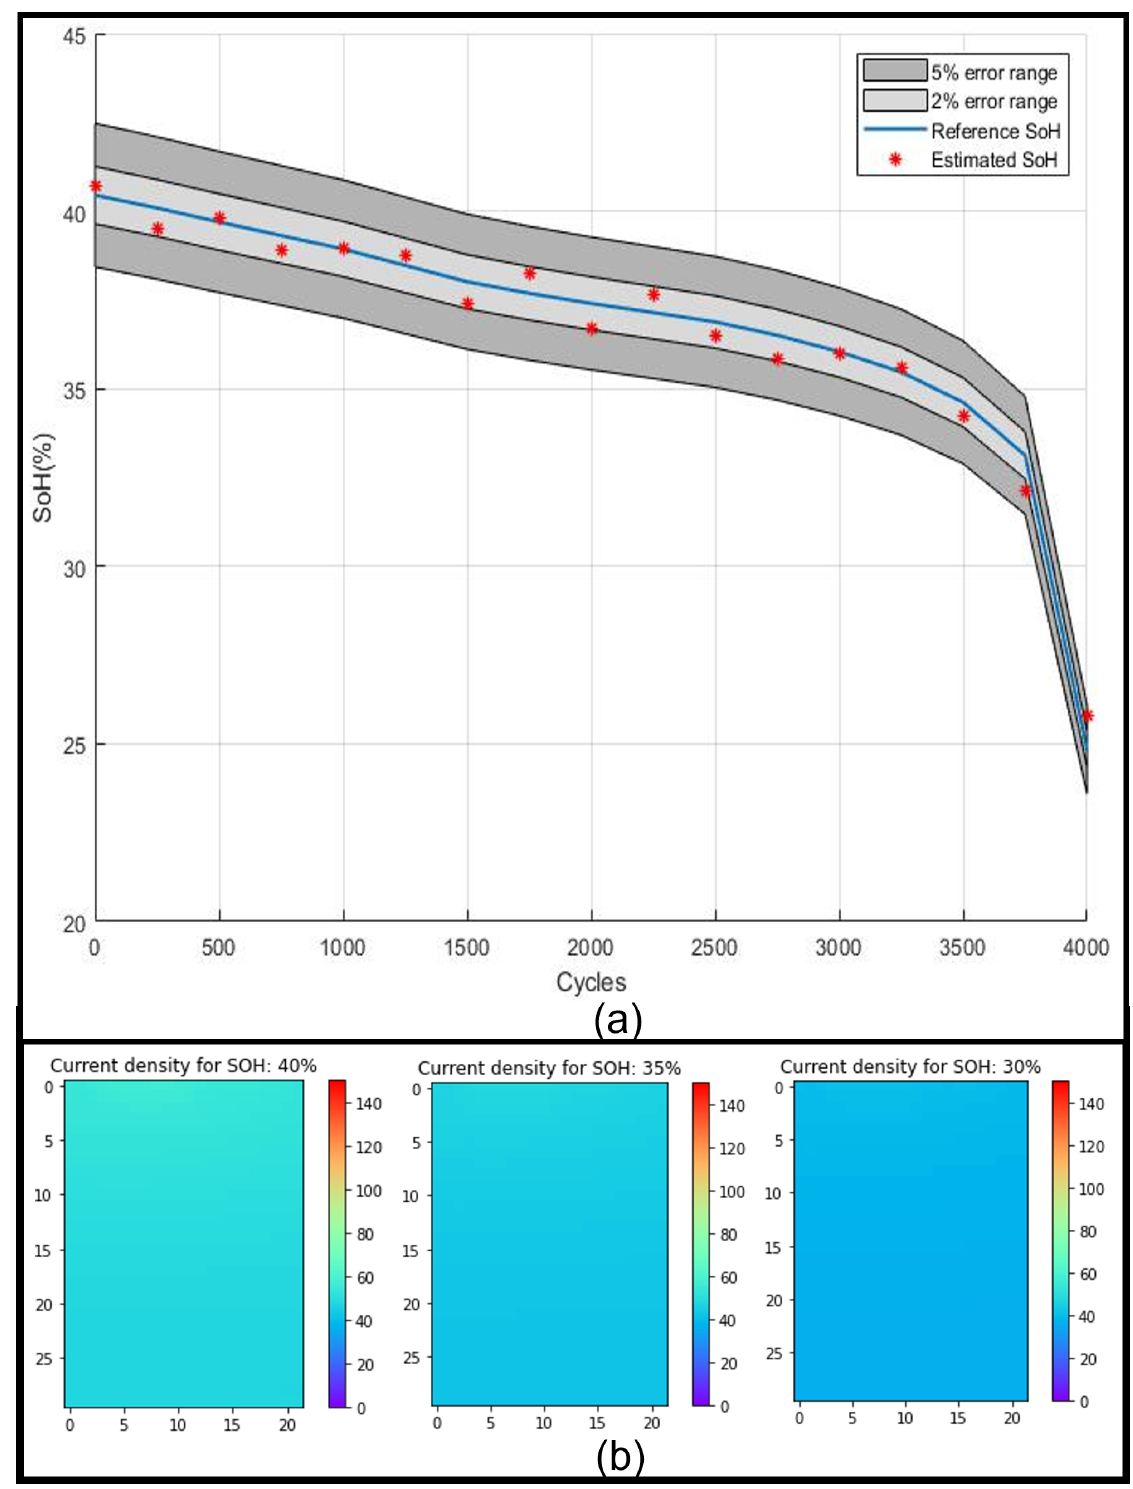
Figure 13. ( a ) SoH(%) estimation results for the aged cell. ( b ) Captured CDIs from the aged